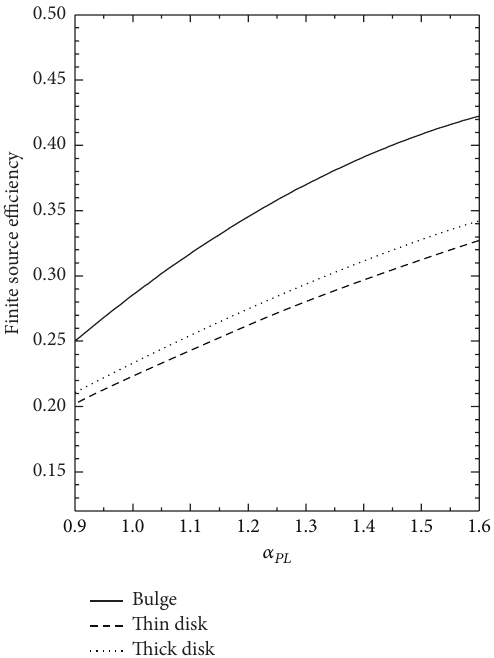
Figure 4: The finite source efficiency for microlensing events by FFPs as a function of 𝛼 𝑃𝐿 for the three different distributions of FFPs: bulge (continuous line), thin disk (dashed line), and thick disk (dotted line) considered